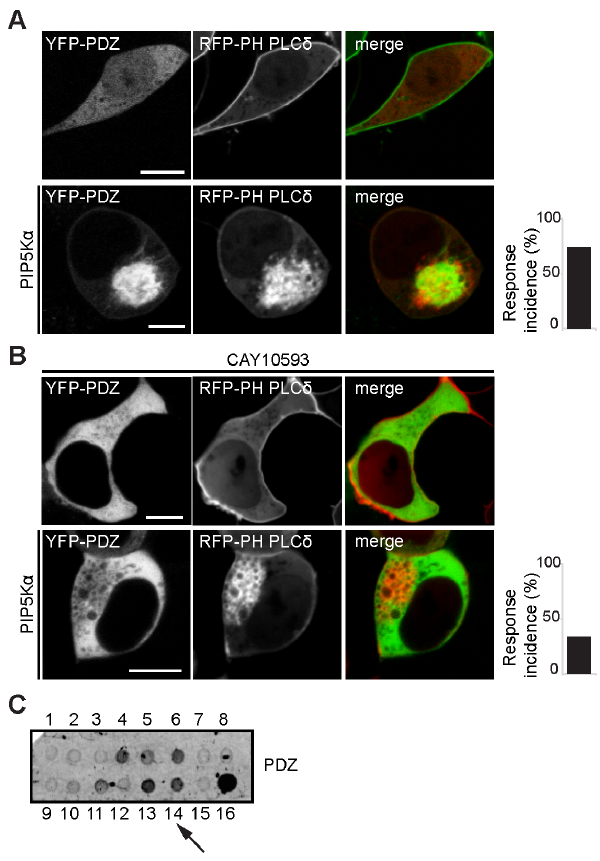
Figure 2. The PDZ domain of PDZGEF binds to phosphatidic acid. A. The PDZ domain of PDZGEF (CFP-PDZ) in HEK293T cells shows vesicular localization in the presence of PIP5K a . B. Treatment of HEK293T cells with the PLD1 inhibitor CAY10593 impairs association of the PDZ domain (CFP-PDZ) with locally generated PA on PIP5K a – generated vesicles. The bar graphs show the percentage of cells showing vesicular localization of the protein in the presence of PIP5K a (8/11 cells for CFP-PDZ and 4/12 cells for CFP-PDZ in presence of CAY10593). All scale bars: 10 m m. C. Protein-lipid overlay assay of HA tagged PDZ domain of PDZGEF1 (PDZ) isolated from HEK293T cells using PIP strips containing 100pmol/spot of the following lipids: 1: lysophosphatidic acid (LPA), 2: lysophosphocholine (LPC), 3: phospha- tidylinositol (PI), 4: phosphatidylinositol 3-phosphate [PI(3)P], 5: PI(4)P, 6: phosphatidylinositol 5-phosphate [PI(5)P], 7: